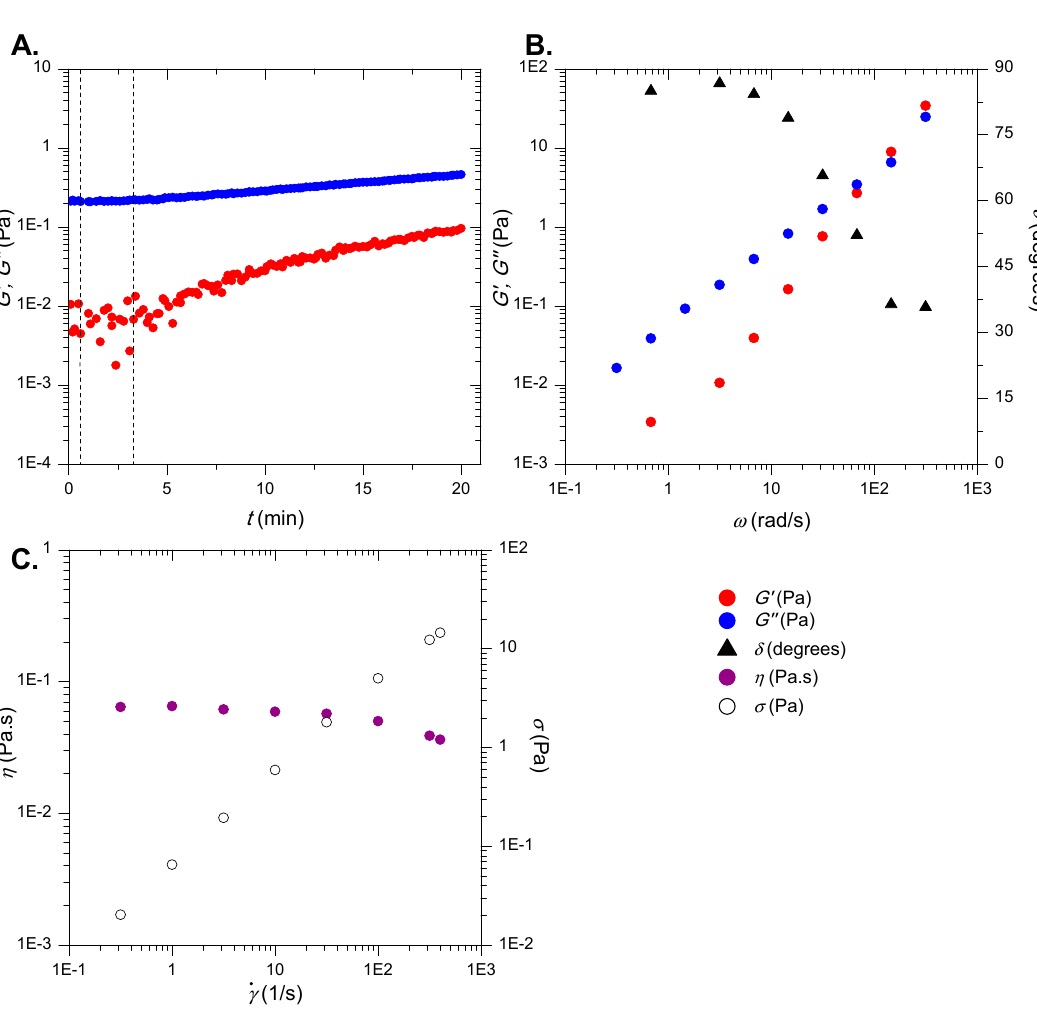
Figure 1. Time Sweep ( A ), Frequency Sweep ( B ), and Flow Step ( C ) for a model hyaluronic acid (HA) solution with a HA concentration of 5 mg/mL, at 37.5 °C.